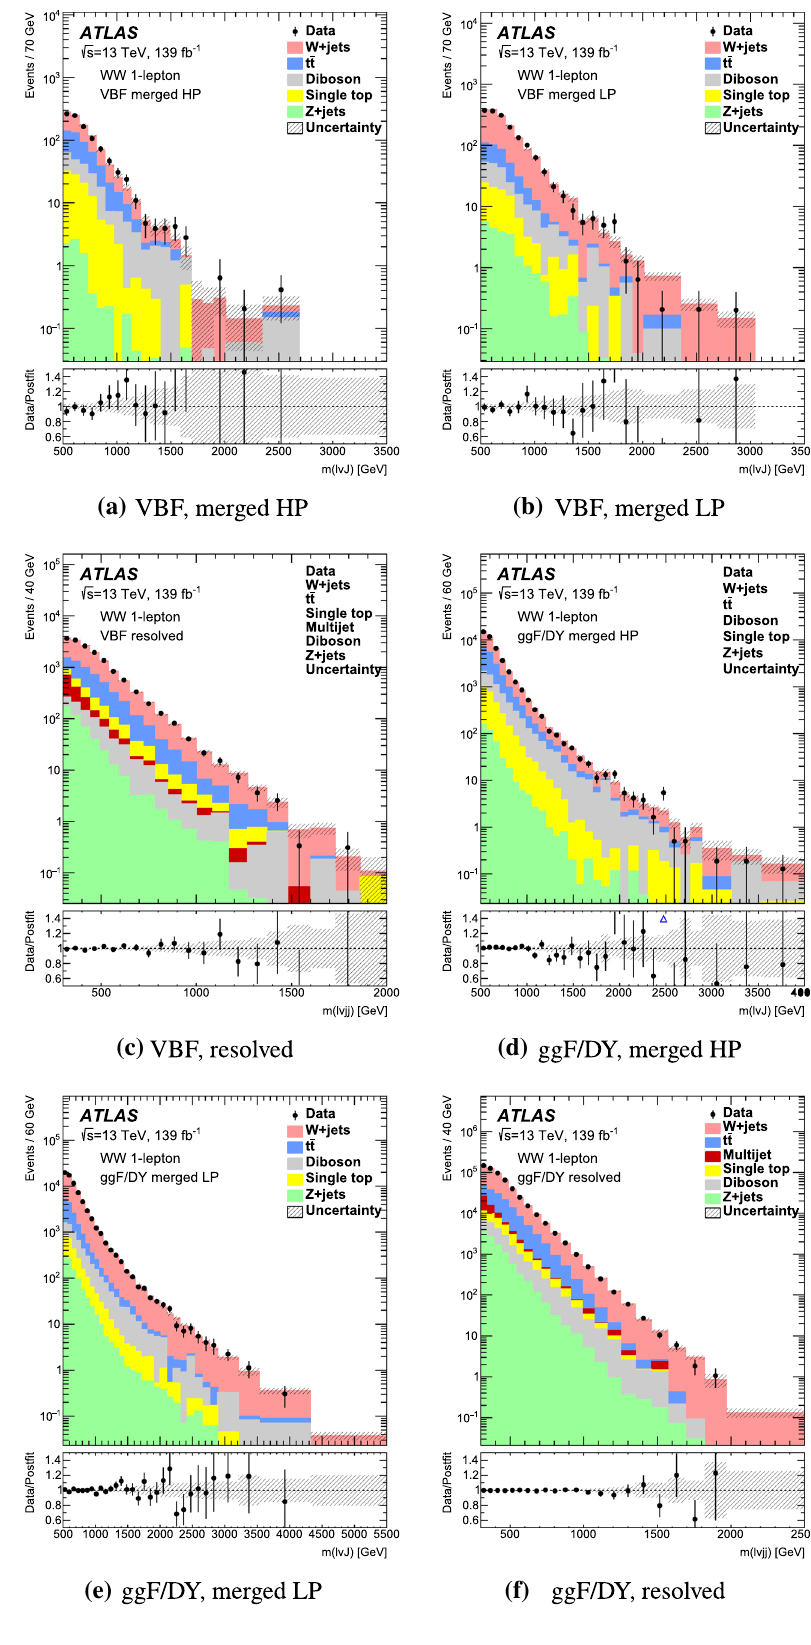
Fig. 10 Comparisons of the observed data and the expected background distributions of m (cid:4)ν jj or m (cid:4)ν J in the 6 WW SRs of the 1-lepton channel. The background predictions are obtained through a background-only simultaneous fit to the 6 WW and 15 Z Z SRs and their respective V + jets and t ¯ t CRs (see text). The bottom panes show the ratios of the observed data to the background predictions. The blue triangles indicate bins where the ratio is non-zero and outside the vertical range of the plot. The hatched bands represent the uncertainties in the total background predictions, combining statistical and systematic